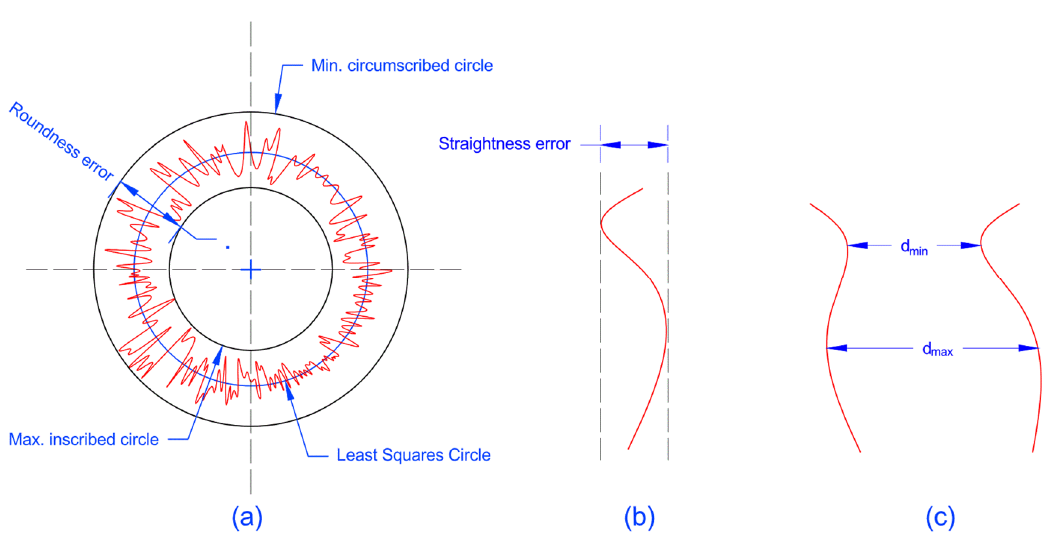
Figure 6. ( a ) Roundness error; ( b ) Straightness error; ( c ) Parallelism error.